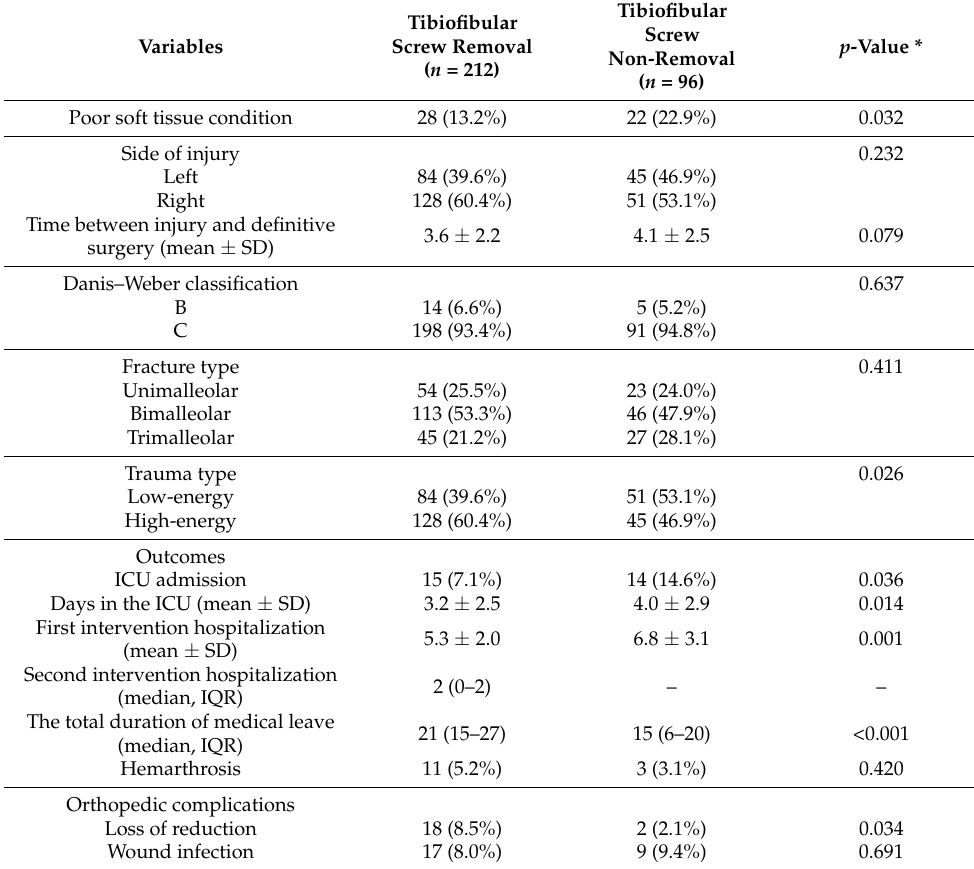
Table 2. Orthopedic features and imaging